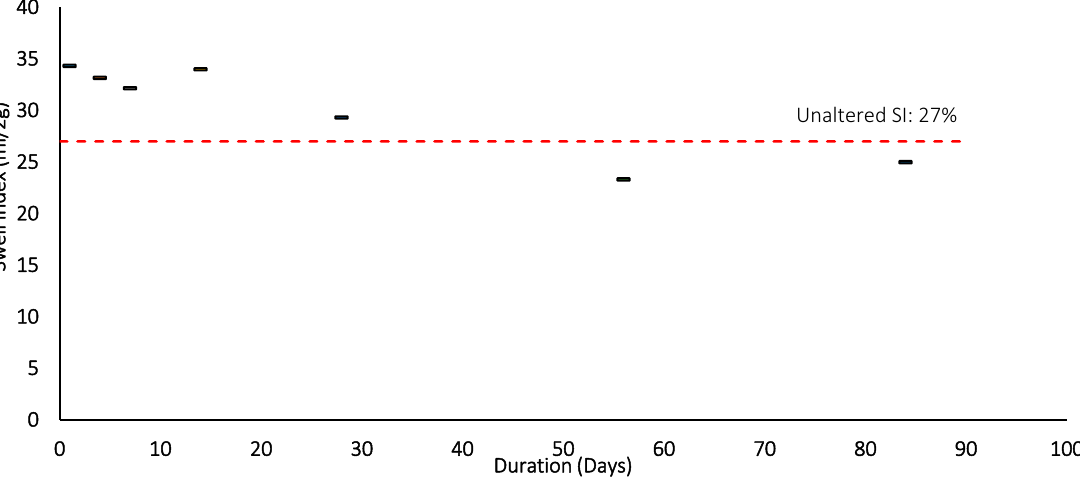
Figure 14. Swell index after Thermal loading (105 °C) and duration.